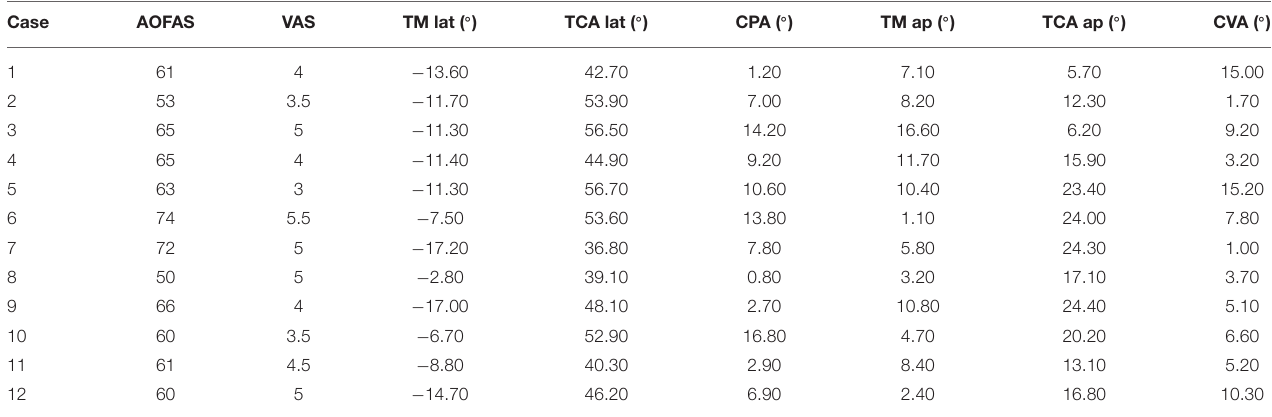
TABLE 2 | Preoperative clinical and radiographic